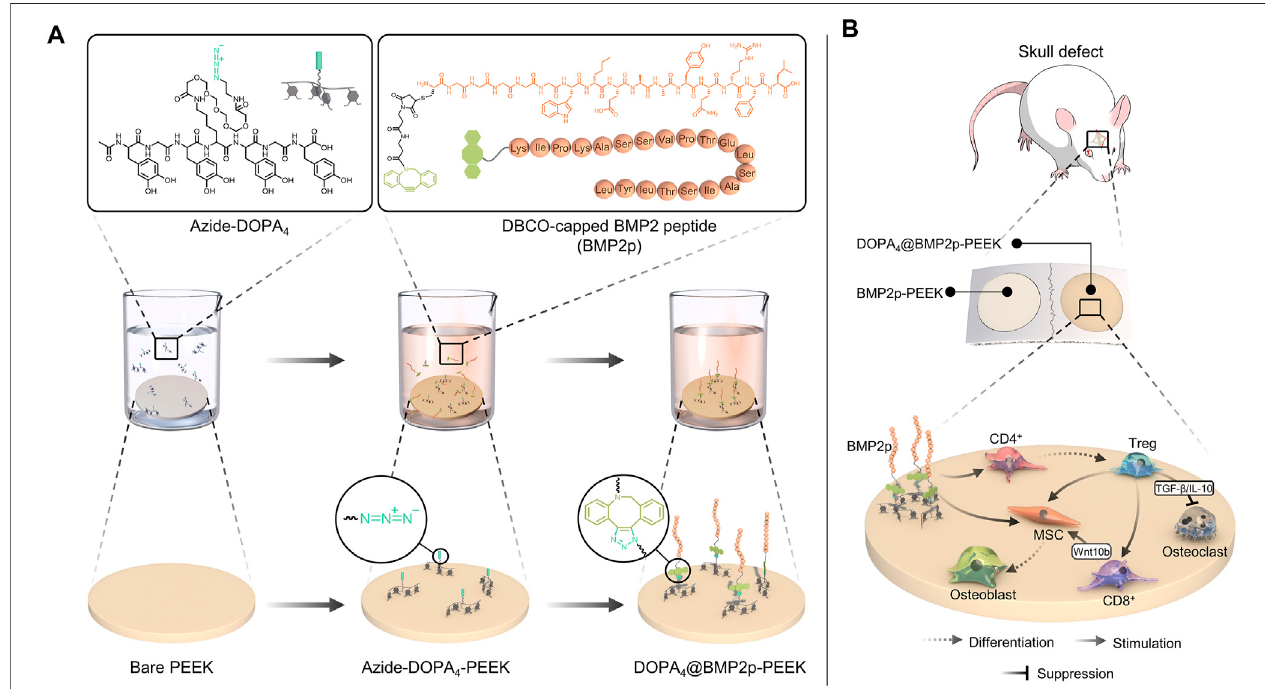
Schematic diagram of osteogenic and immunoregulatory effects of the DOPA 4 @BMP2p PEEK material.